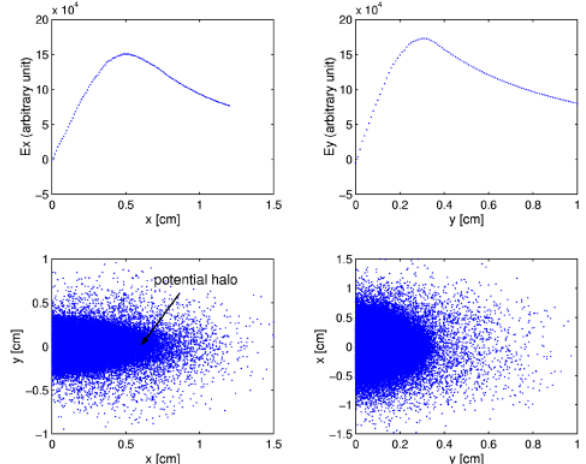
FIG. 5. (Color) Plots of E field and real space projections of beam distribution. Ex is plotted along the x axis and Ey along the y axis. The unit of E field is arbitrary. x rms beam size is 3.40 mm and y rms beam size is 1.71 mm.